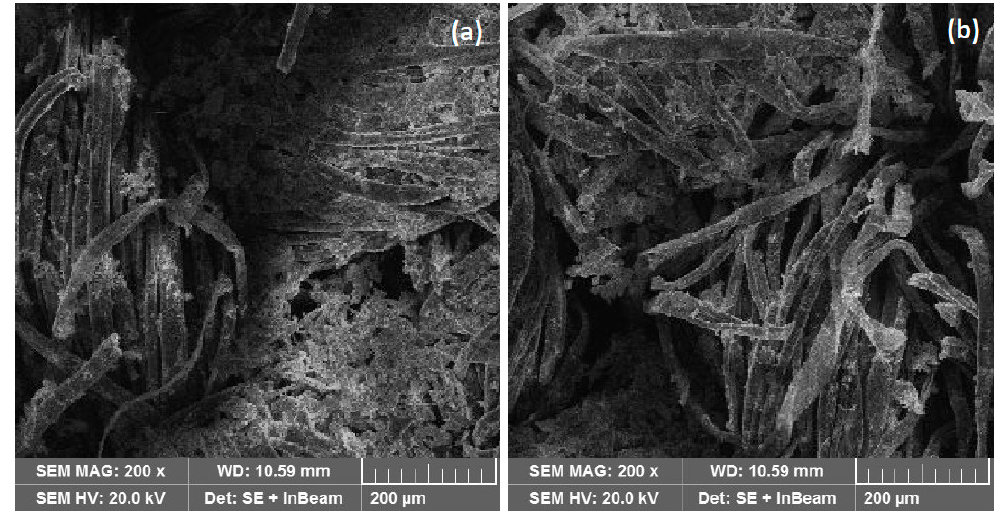
Figure 8. SEM images of the ( a ) optimum sample after five washing cycles and ( b ) control sample after five washing cycles.